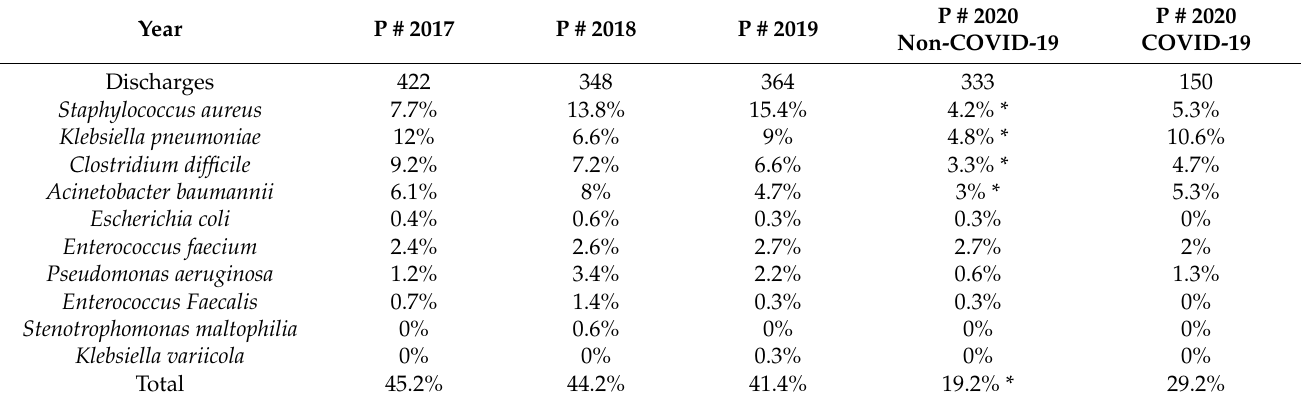
Table 1. Data from medical departments during the period (P#) from 1 March to 30 June in 2017, 2018, 2019 and 2020. The first row indicates the year analyzed. During P# 2020, COVID-19 and non-COVID-19 departments were analyzed separately. The second row shows the number of discharges. The following rows show the infection incidence of each pathogen. The last row indicates the total incidence of infections from any type of multidrug-resistant (MDR) bacteria. The p -value refers to the years before the